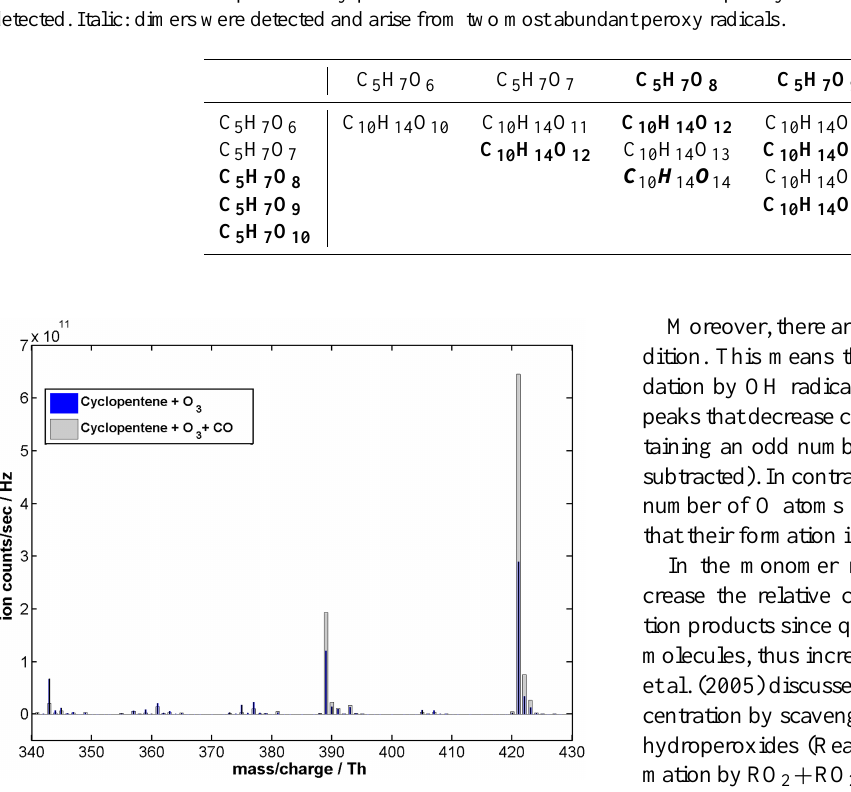
Figure 7. Comparison of the dimer HOM spectra resulting from ozonolysis of cyclopentene with CO addition (gray) and without CO addition (blue). The fraction of dimers which involve the O 3 – peroxy radical from the addition of OH to the double bond of cy- clopentene are